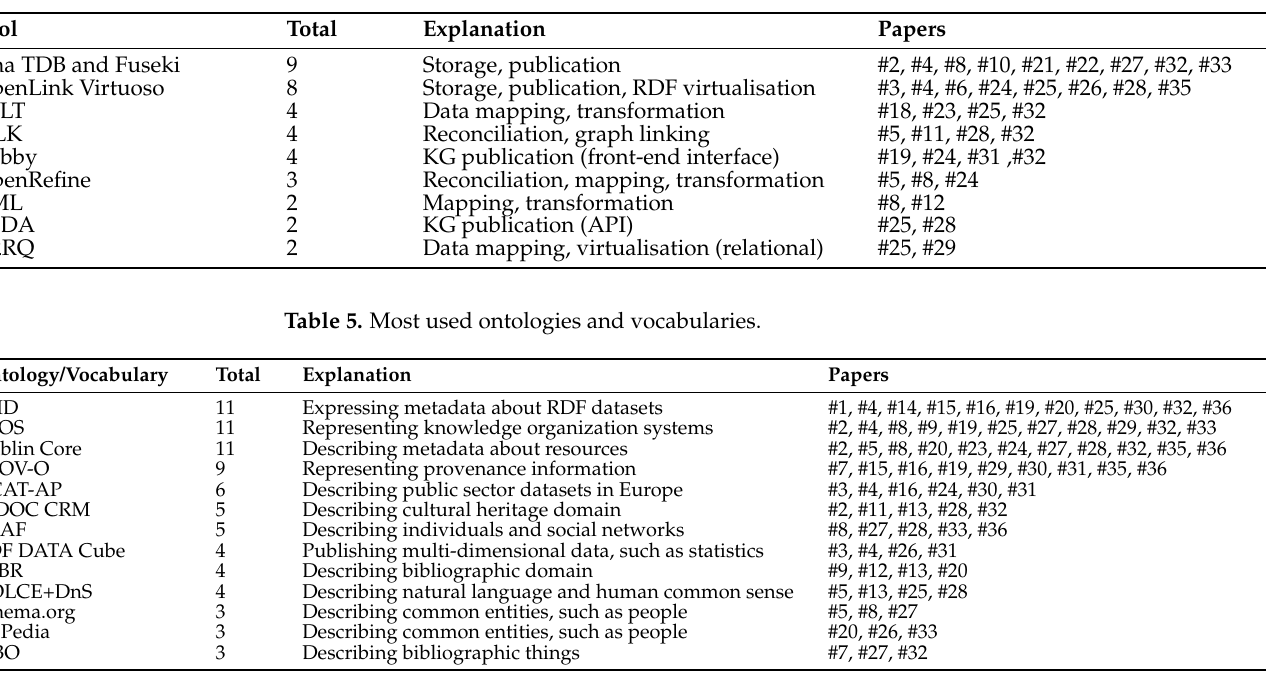
Table 4. Most used tools.